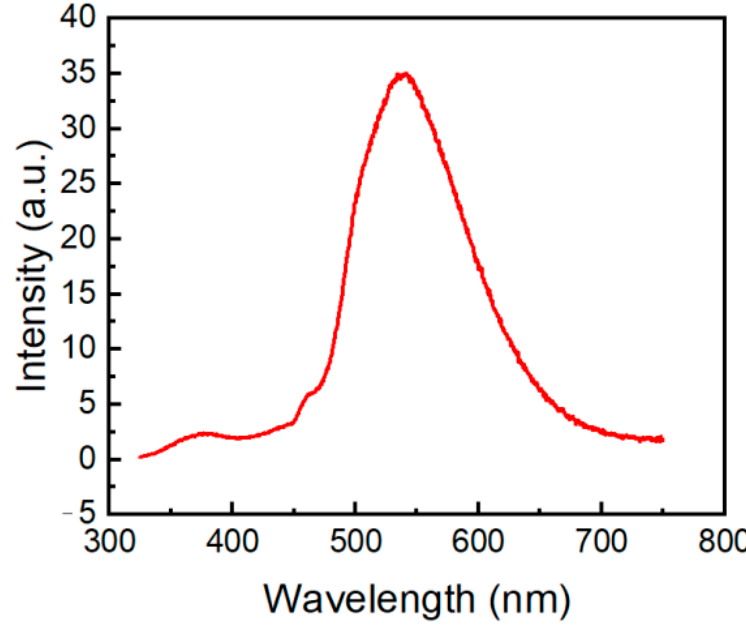
Figure 11. Phosphorescence spectrum of compound 2a in solid state excited at 300 nm.